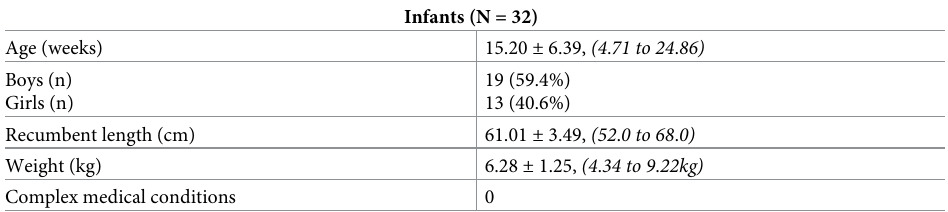
Table 1. Participant